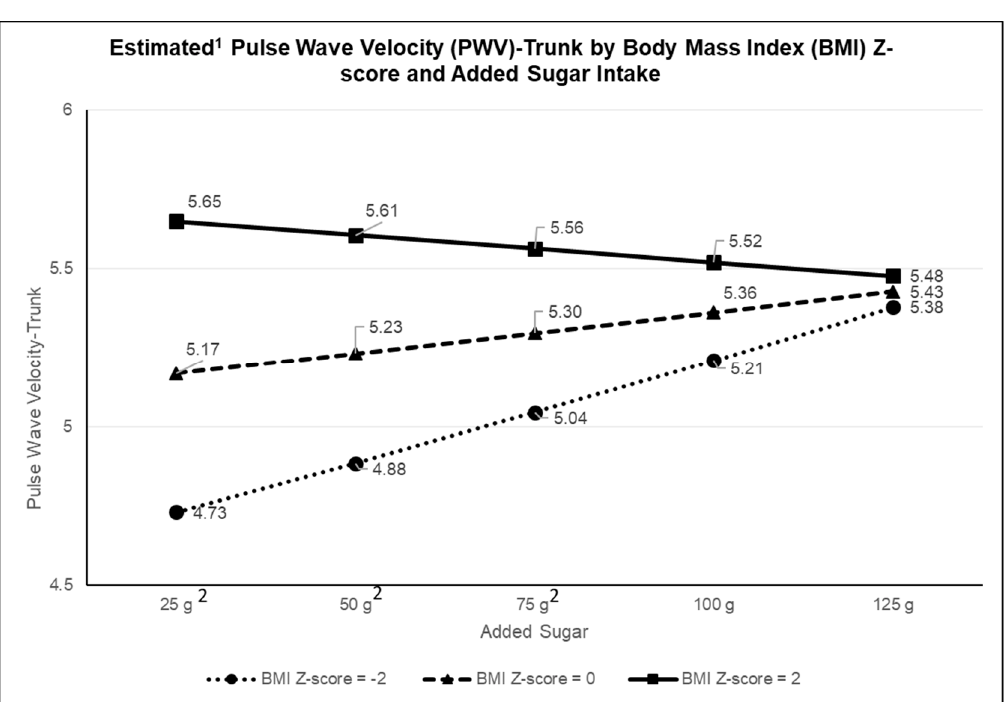
Figure 1. Body mass index modifies the association between cross-sectionally assessed added sugar intake and pulse wave velocity (PWV)-trunk measurements. 1 Estimated PWV-Trunk back-transformed from log-PWV trunk, adjusted for heart rate, mean arterial pressure, calories, age at visit, sex, race / ethnicity, parental education, diabetes duration, insulin regimen, and Healthy Eating Index-2015 without added sugar component. 2 Pairwise test, P value < 0.001.